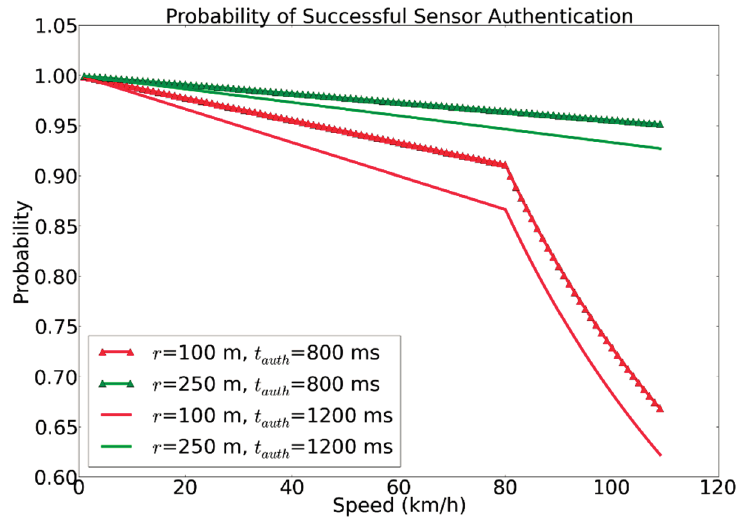
Figure 11. Probability of successful sensor authentication with mobile gateways traveling at higher speeds based on authentication